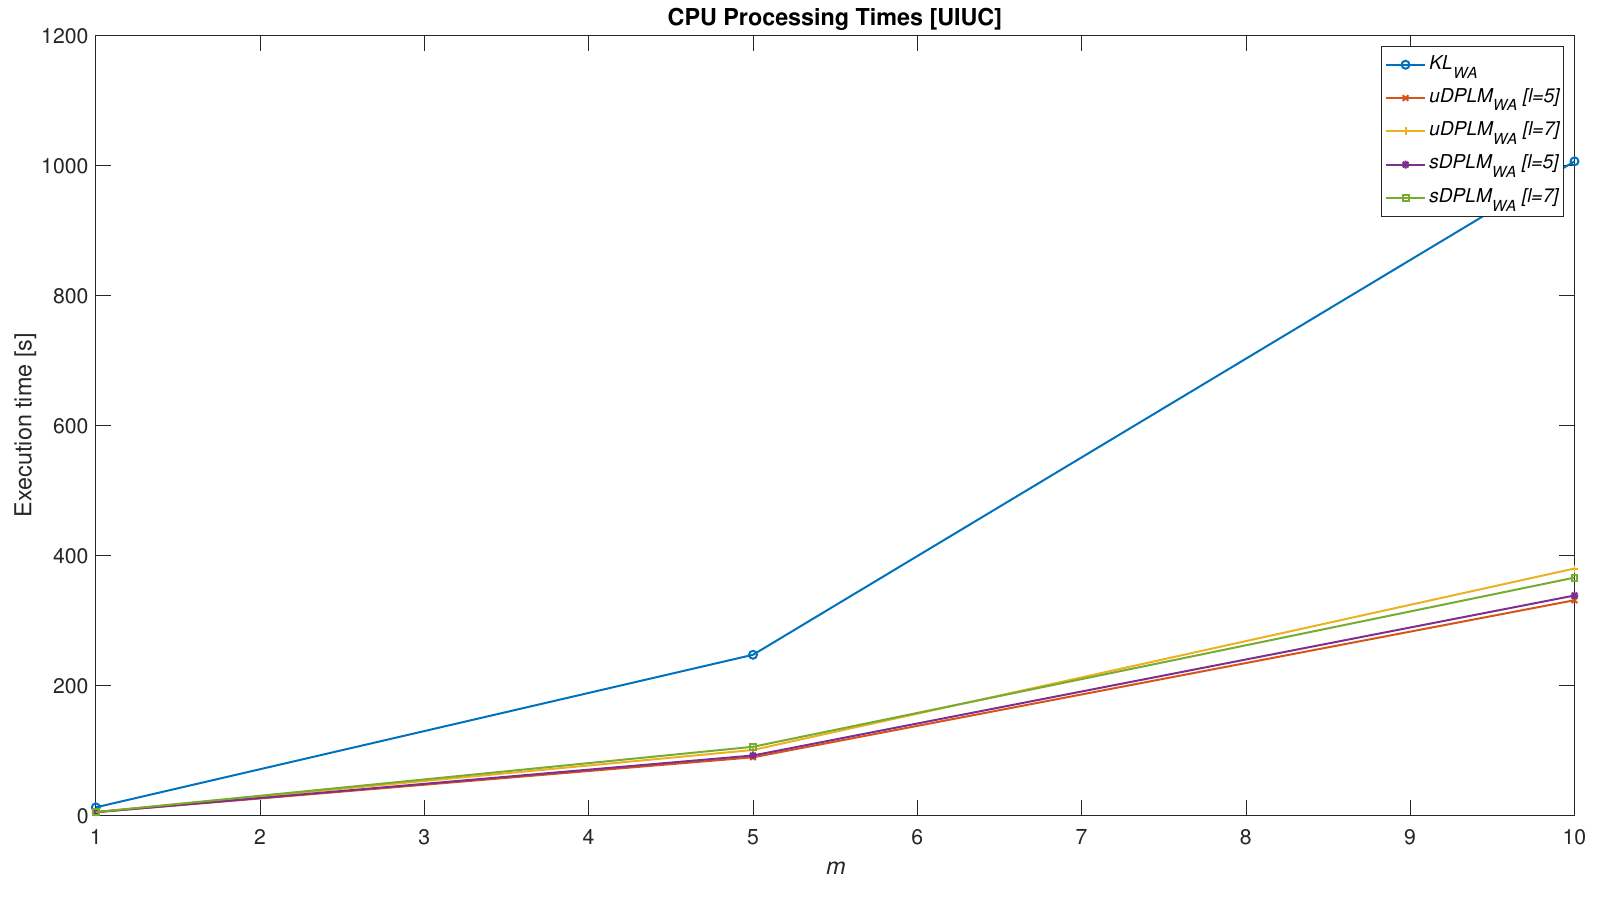
Figure 2. CPU processing times for the UIUC database, DPLM WA vs. KL WA